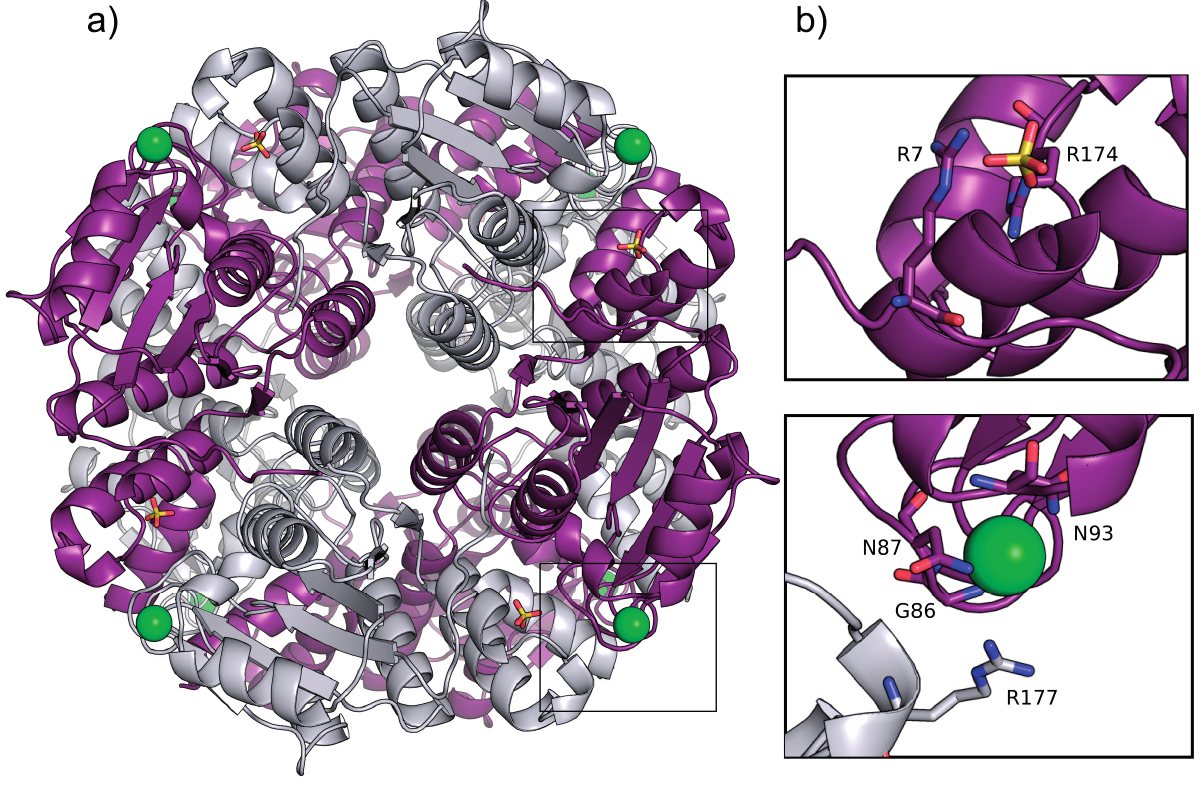
Figure 1. ( a ) Ribbon representation of P. aeruginosa YcaC octamer in crystal form I with chains alternately colored purple and silver, chloride as green spheres and sulfate as sticks with orange sulfur and red oxygens; ( b ) Close-up of the sulfate and chloride binding sites in chain A shown in purple with chain B depicted in silver. Stacked Arg 7 and 174 with the sulfate are shown in ball-and-stick representation. The chloride is shown with coordinating residues Gly86, Asn87 and Asn93 and the lid-forming Arg177 from chain B. The pin-wheel arrangement of YcaC appears to be vital to the function of the more closely-related enzymes, since each putative active site is made up of residues from one chain and the C-terminus of the neighboring chain. This C-terminal region from residue 165 and onwards contains three alpha-helices and a loop with what looks like a single-wind